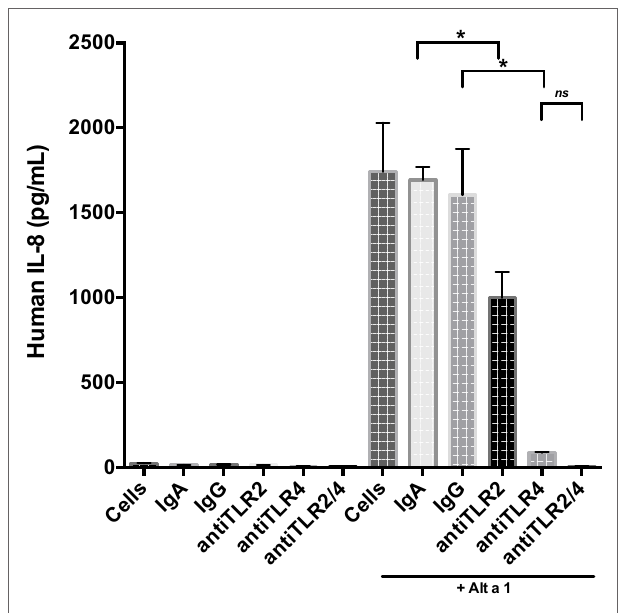
FigUre 5 | Alt a 1 primarily induces innate immunity through toll-like receptor (TLR)4 in BEAS-2B cells. 2.5 × 10 5 BEAS-2B cells were grown in RPMI + FPS + 1% Pen Strep. Cells were washed 24 h before use. They were then starved for 6 h. The starve media was RPMI + 1% Pen Strep. Some cells were pretreated with 10 µg/mL anti-hTLR2-IgA, 10 µg/mL anti-hTLR4-IgG, 10 µg/mL human IgA2-control, or 10 µg/mL mouse-IgG1- control for 1 h, then given 50 µg rAlt a 1. Cells incubated for 24 h. Media was collected and assayed via BIOLEGEND IL-8 ELISAMAX. Data are represented as mean (SD). After testing for homogeneity of variances, Tukey’s HSD was performed and adjusted (if applicable) (* p < 0.001). The anti-hTLR2-IgA Alt a 1 treatment was compared to the Alt a 1-IgG treated control. The anti-hTLR4-IgG treatment was compared to the Alt a 1-IgG treated control. Alta1 + TLR2/4 treatment is significant when compared to the Alt a 1-IgG treated control or Alta1 + hTLR2 and is designated with an asterisk. However, Alta1 + hTLR2/4 is not significant when compared to Alta1 +